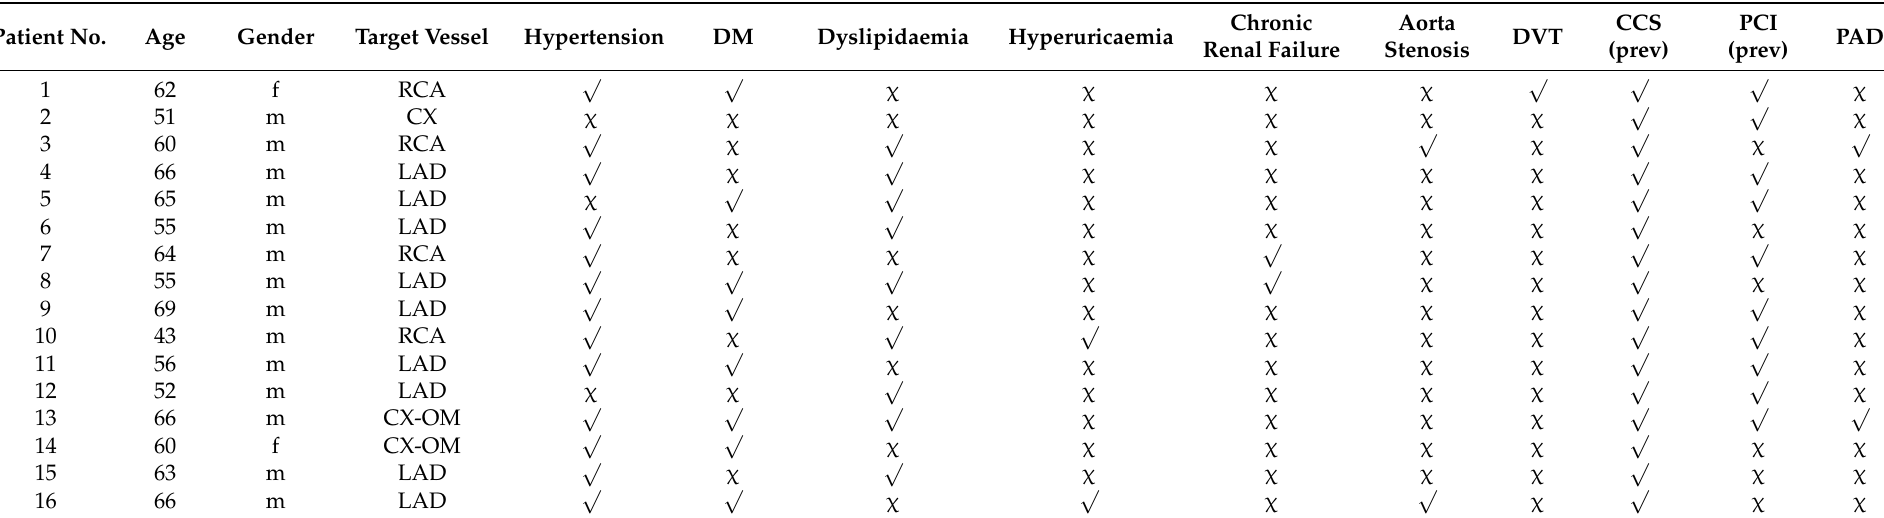
Table 1. Clinical